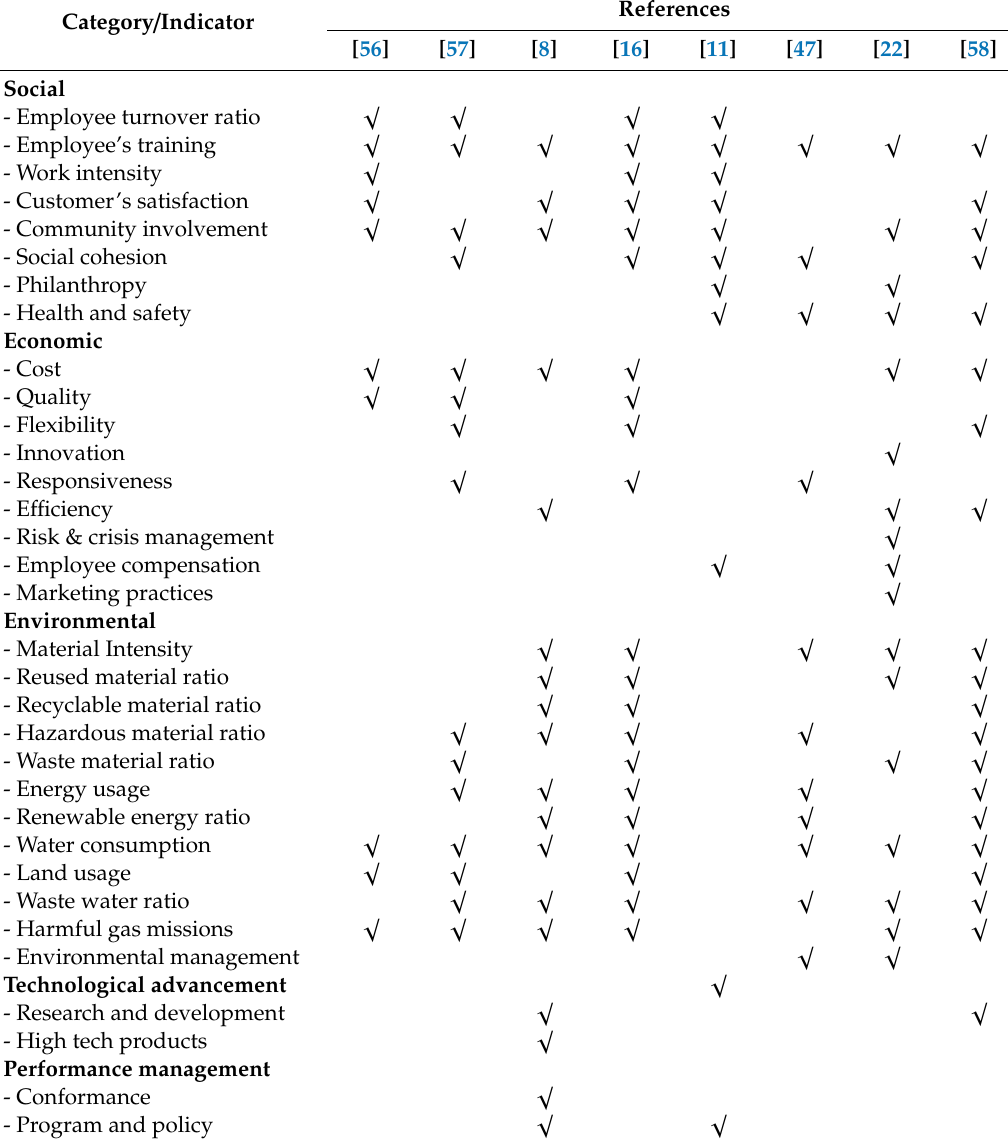
Table 1. List of vital performance indicators regarding the sustainability of the manufacturing